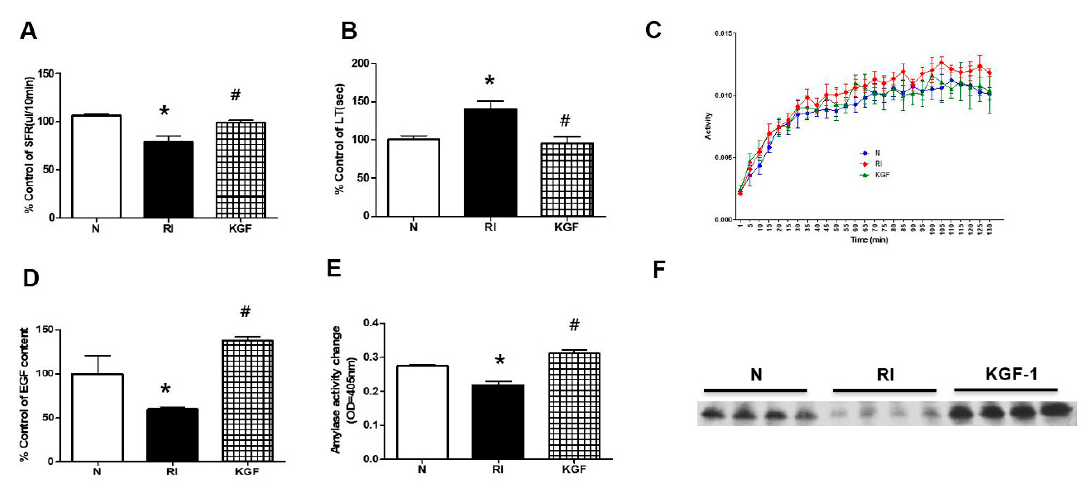
Figure 3. Histological analysis of salivary glands. ( A ) Representative histological images of PAS and MT staining. More mucin-containing acini and less periductal fibrosis were observed in the RI+KGF- 1 group than in the RI group. ( B ) Representative immunohistochemical images showing HIF1a, salivary epithelial cells (AQP5 stained) and endothelial cells (CD31 stained). The expression of HIF1a was higher and the expressions of AQP5 and CD31 were lower in the RI group than in treatment naïve controls. HIF1a staining intensities was lesser, and AQP5 and CD31 staining intensities were greater in the RI+KGF-1 group than in the RI group. (N; treatment naïve control group, RI; RI group, KGF; RI+KGF-1 group). Results are presented as means ± SDs; *, vs. treatment naïve controls; # , vs. the RI group. * p < 0.05, # p < 0.05 ( n = 6 mice per group) (N; treatment naïve controls, RI; RI group, KGF; RI+KGF-1 group), Scale bar: 50 µm. ( C ) More mucin-containing acini and less periductal fibrosis were observed in the RI+KGF-1 group than in the RI group. The expression of HIF1a was higher and the expressions of AQP5 and CD31 were lower in the RI group than in treatment naïve controls. HIF1a